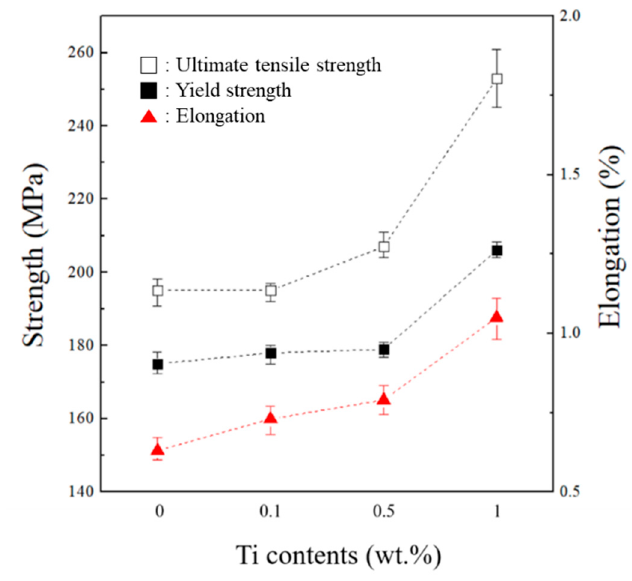
Figure 10. Mechanical properties of Al-8Zn-6Si-4Mg-2Cu alloys with different Ti contents.